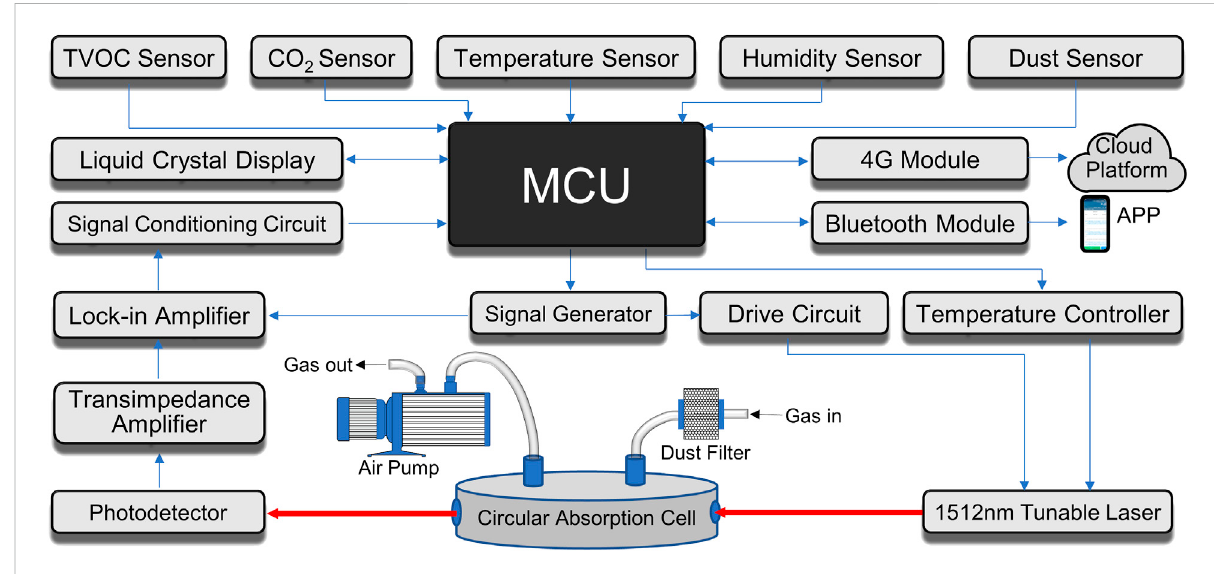
FIGURE 1 Schematic diagram of the sensor for monitoring NH 3 gas based on the TDLAS technology and other environmental parameters in the poultry